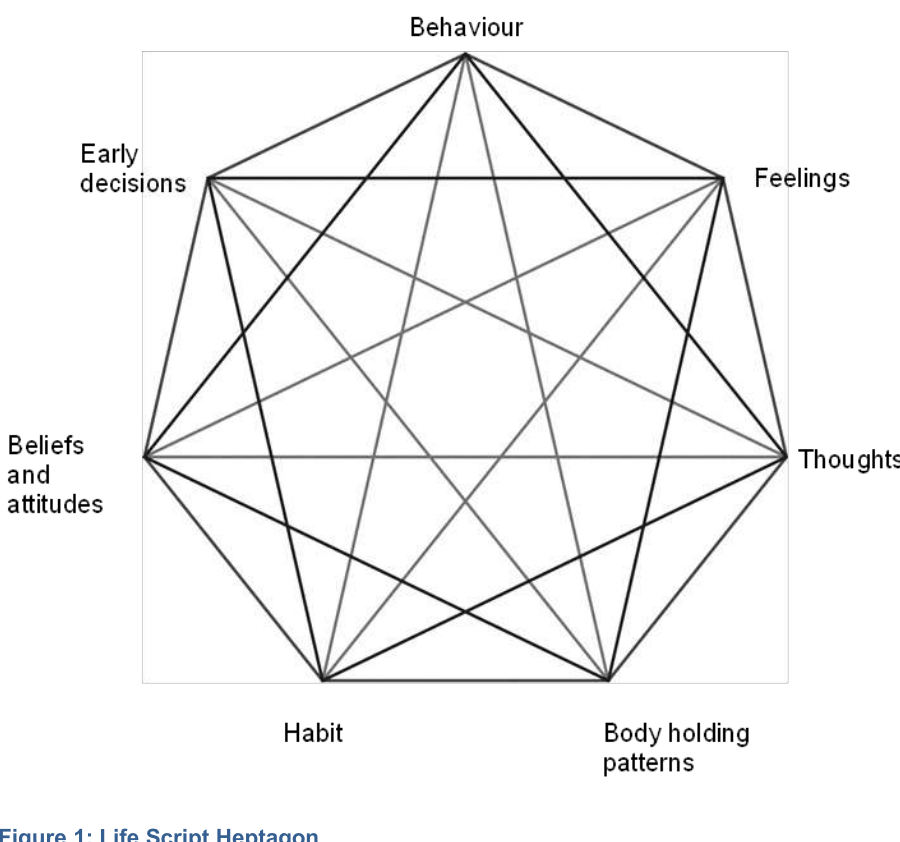
Figure 1: Life Script Heptagon